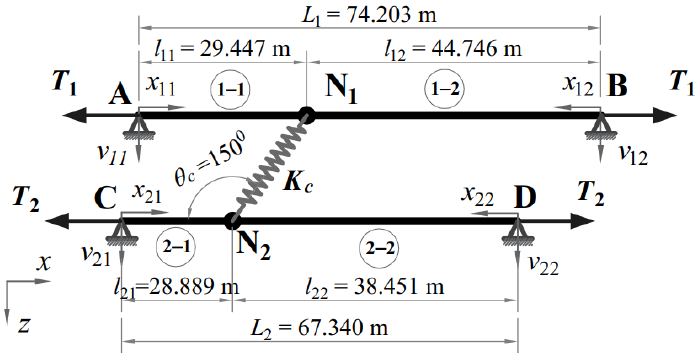
Figure 10. Equivalent configuration of the cable network.